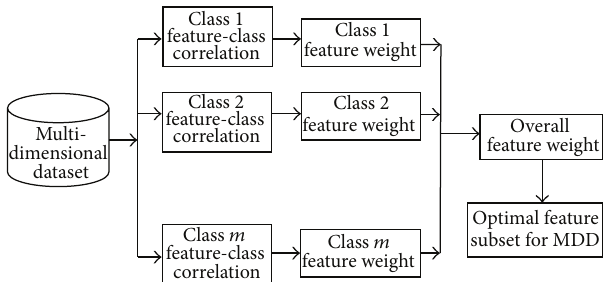
Figure 2: Proposed MFSS for multidimensional